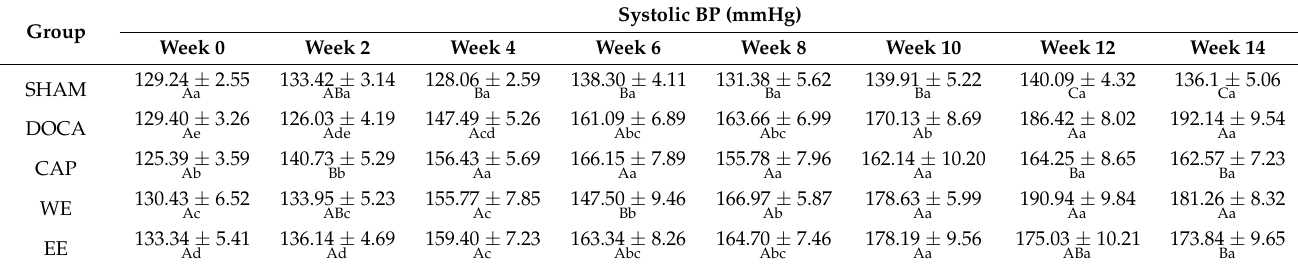
Table 1. Effects of administration of the water extract and ethanol extract of L. rhamnosus AC1- fermented soymilk on blood pressure in DOCA-salt hypertensive